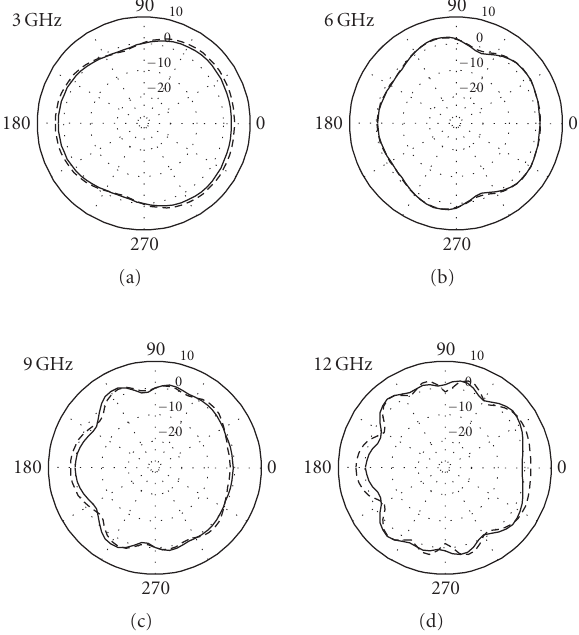
Figure 6: Expected azimuth (X-Y plane) radiation pattern for two antennas (solid line) and SC approximation (dashed line). Antenna 1 is excited; antenna 2 is open circuited ( d = 50